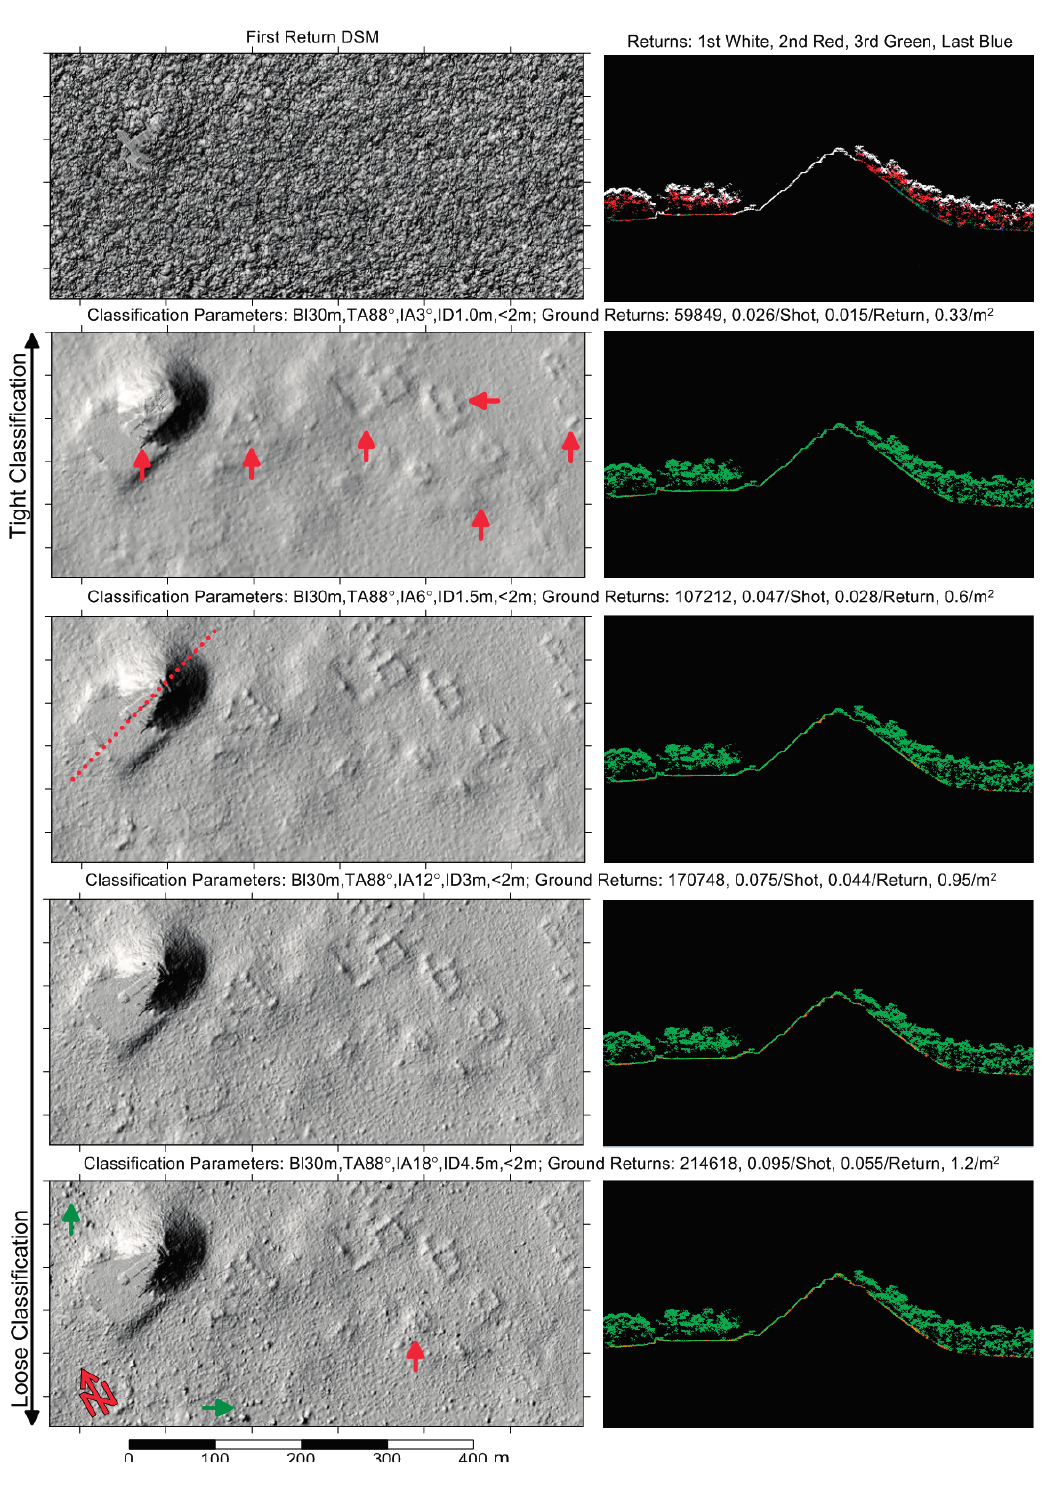
Figure 19. Illustration of tight ( top ) vs. loose ( bottom ) ground classification results. ( a ) First return DSM and cross section coloring returns based on its ordinal attribute; ( b ) ground return DEM and cross section coloring returns based on its class from a very tight classification; ( c ) results from a balanced classification; ( d ) results from a loose classification; ( e ) results from a very loose